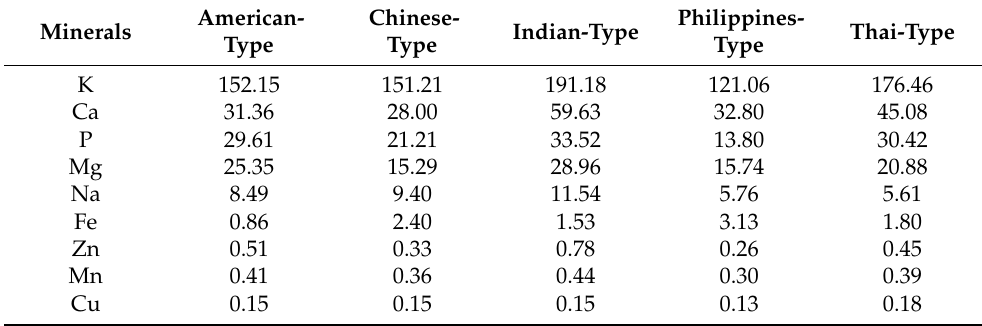
Table 5. Mineral content of eggplant cultivars (mg/100 g) on a fresh weight basis [18].